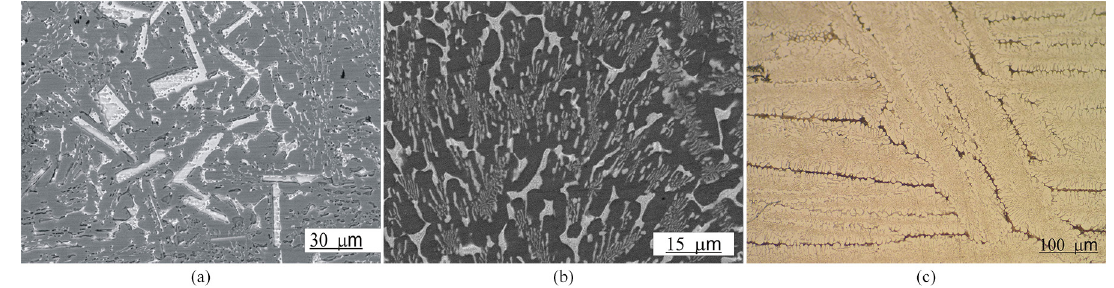
Figure 3. Microstructures of the alloys Al‑3.5%Mg‑Zn‑Ca in as‑cast state: (а) 12%Zn and 4%Ca; (b) 11%Zn and 3%Ca; (c) 9%Zn and 4%Ca. (а, b) SEM; (c) OM.